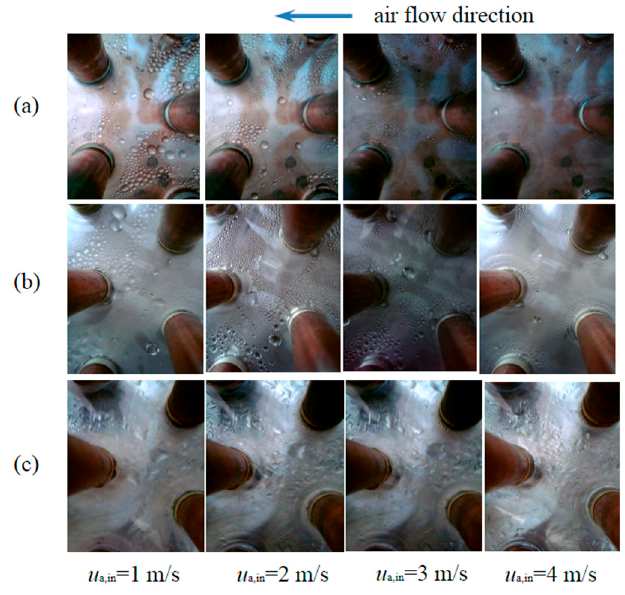
Figure 7. Effect of u a,in on geometry form of condensate water on the fin surfaces of three different